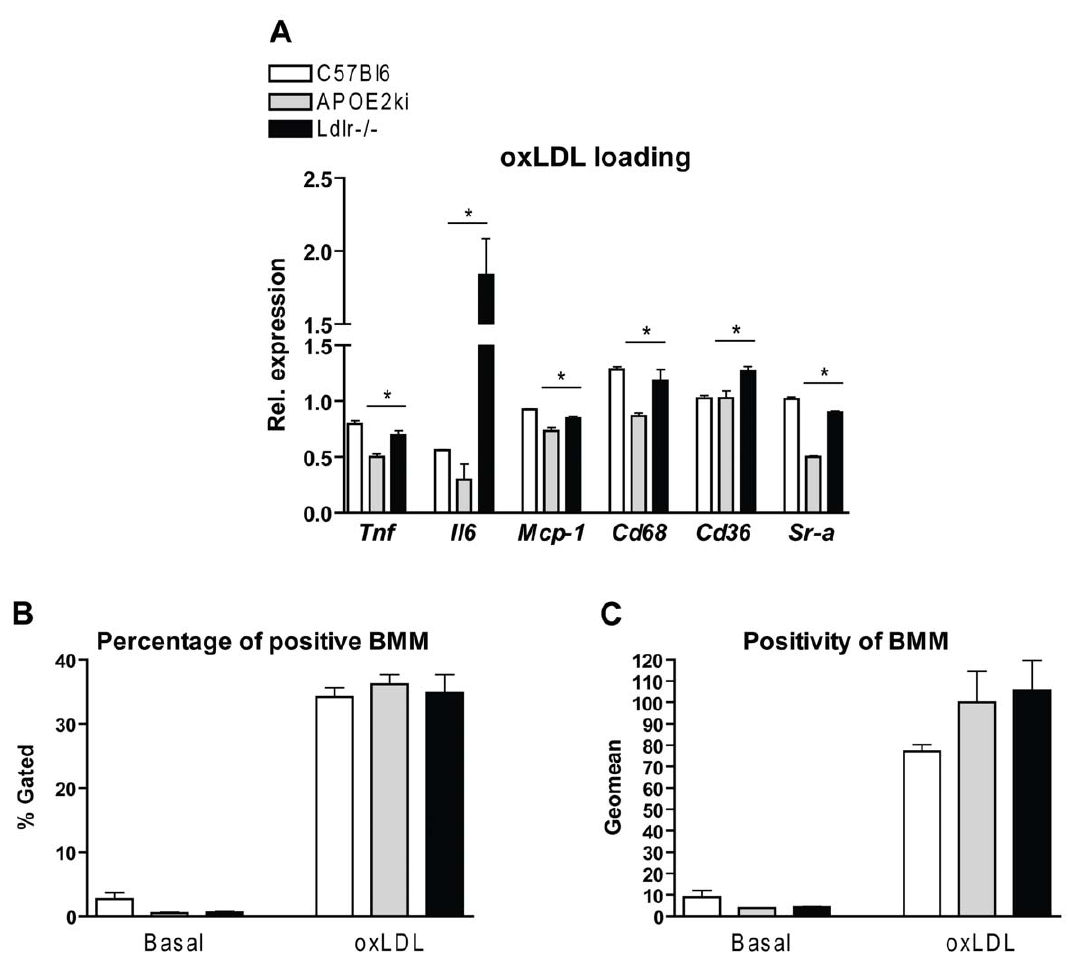
Figure 6. Loading of bone marrow-derived macrophages with oxLDL. (A) Bone marrow-derived macrophages (BMM) of C57Bl6, APOE2ki and Ldlr 2 / 2 mice were loaded with oxidized low-density lipoprotein (oxLDL) and gene expression of tumor necrosis factor (Tnf) , interleukin 6 (Il6) , monocyte chemotactic protein 1 (Mcp-1) , Cd68 , Cd36 and scavenger receptor A (Sr-a) was analysed. Data were set relative to the basal levels of C57Bl6 bone marrow. (B) Percentage of positive BMM at basal levels and after oxLDL loading. (C) Positivity of BMM at basal levels and after oxLDL loading. * indicate p , 0.05.